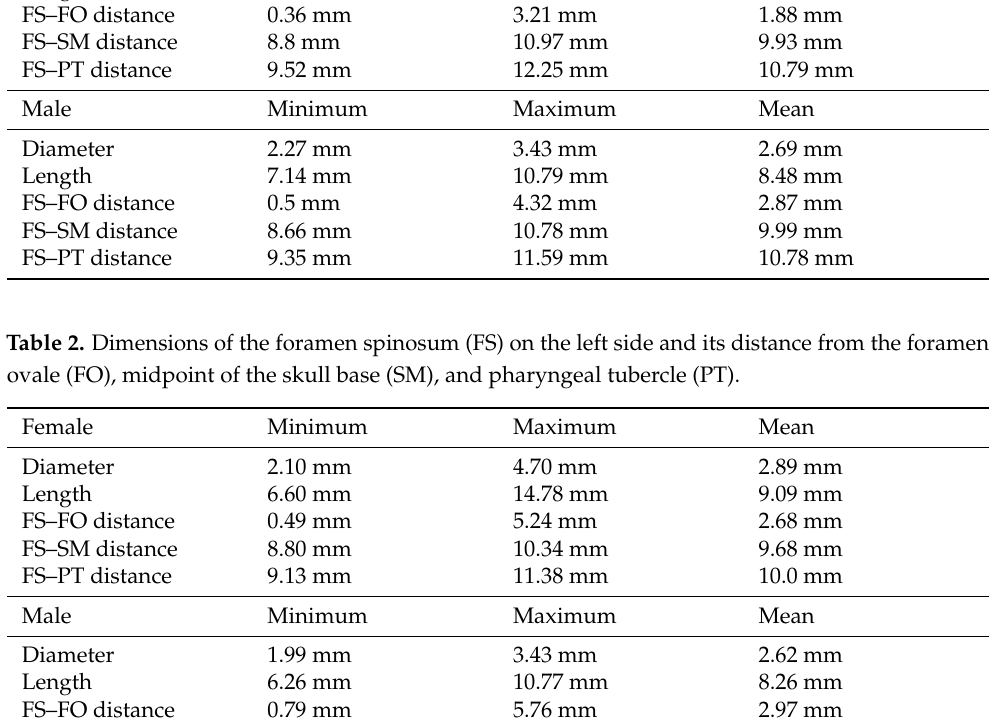
Table 1. Dimensions of the foramen spinosum (FS) on the right side and its distance from the foramen ovale (FO), midpoint of the skull base (SM), and pharyngeal tubercle (PT). Female Minimum Maximum Mean Diameter Length FS–FO distance